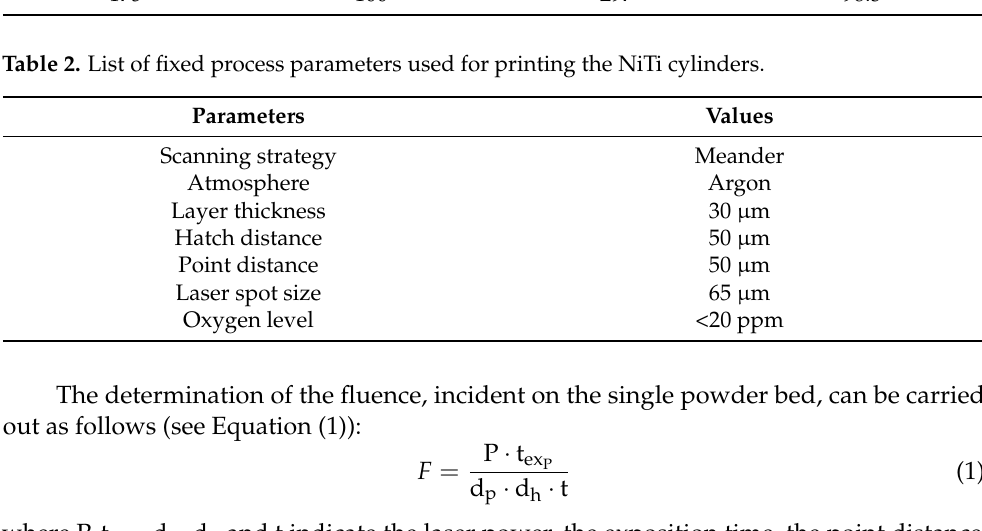
Table 1. List of variable process parameters used for the printing NiTi cylinders. Power [W] Exposure Time [ µ s] Fluence [J/mm 3 ]